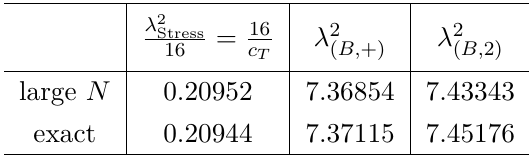
Table 3 . Comparison of the large N formulae to the exact values from [64] for the OPE coefficients of short operators that appear in h 2222 i for U(3) 2 × U(3) − 2 ABJM. κ = 70 , and 1116 binary digits of precision. The most important parameter is Λ , which should be compared to the previously highest value Λ = 43 used in